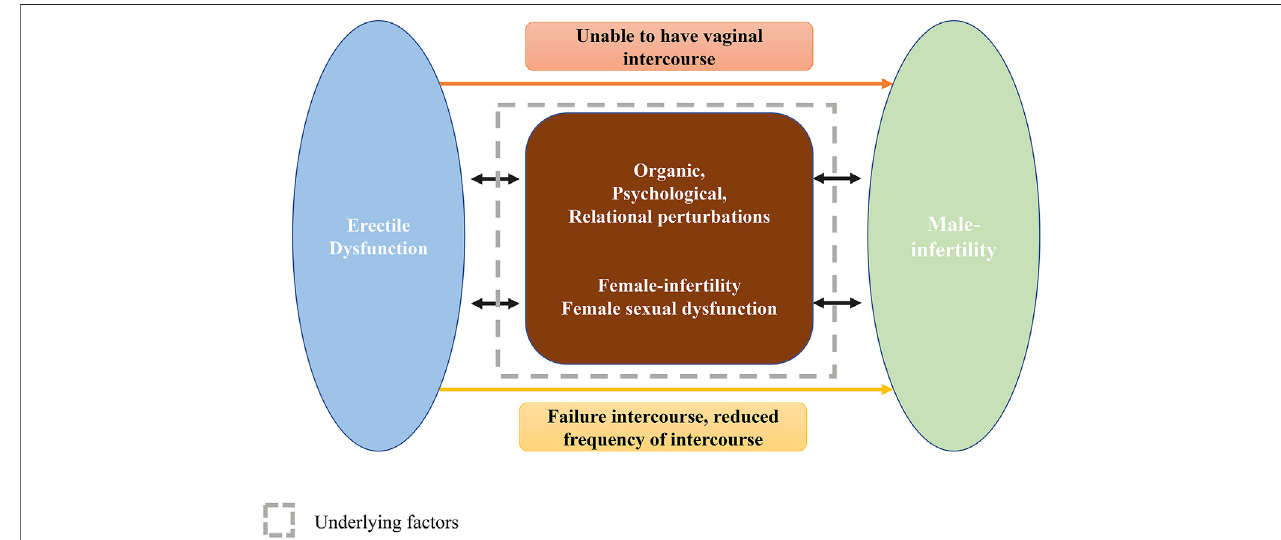
FIGURE 4 | The interplay between ED and male infertility.; Abbreviations: ED: erectile dysfunction.